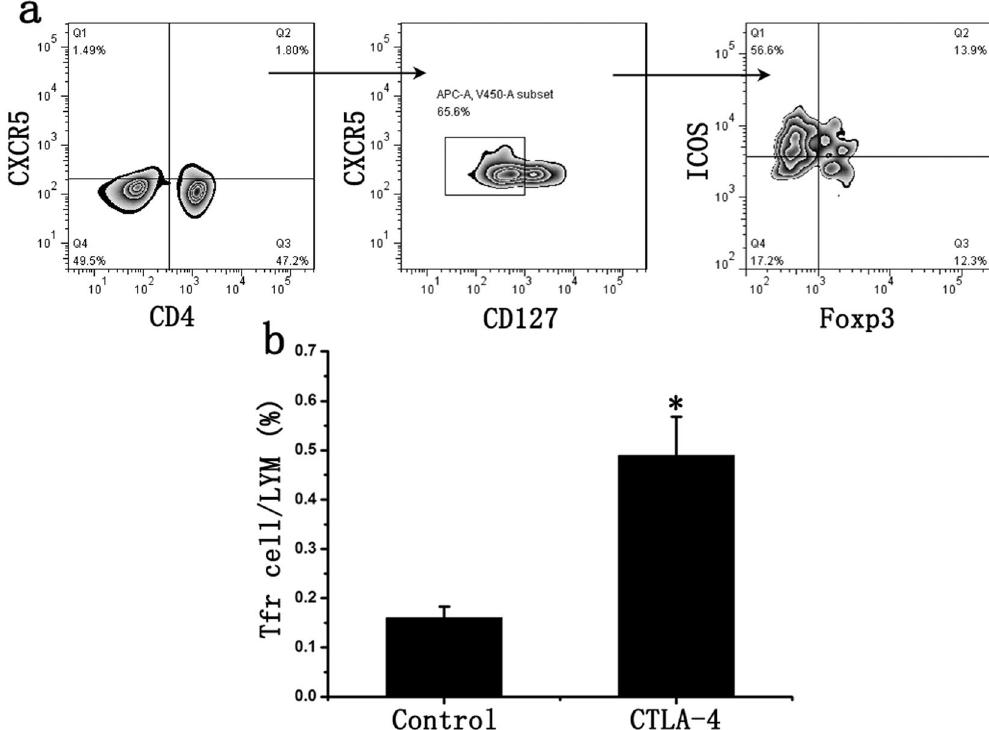
Figure 6. CTLA-4 increased Tfr cell proportion in lymphocyte. ( a ) CD4, CXCR5, ICOS, Foxp3 and CD127 antibodies were used to detect Tfh and Tfr cells; ( b ) CTLA-4 could significantly increase the ratio of Tfr cells in